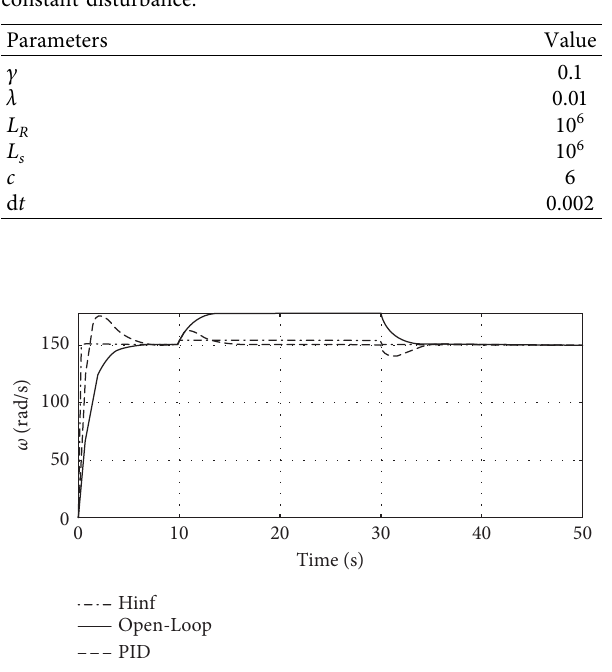
Figure 1: Te angular velocity of the frst order system for τ � 0 . 1s for constant disturbance.